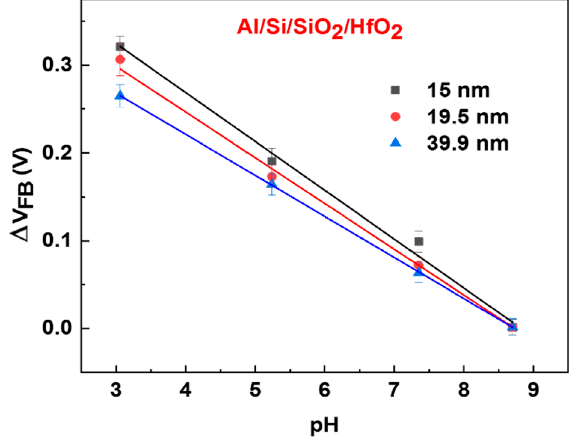
Figure 5. The pH sensitivity for three HfO 2 thicknesses (15.0, 19.5 and 39.9 nm): Δ V FB as a function of pH (from 3 to 9).